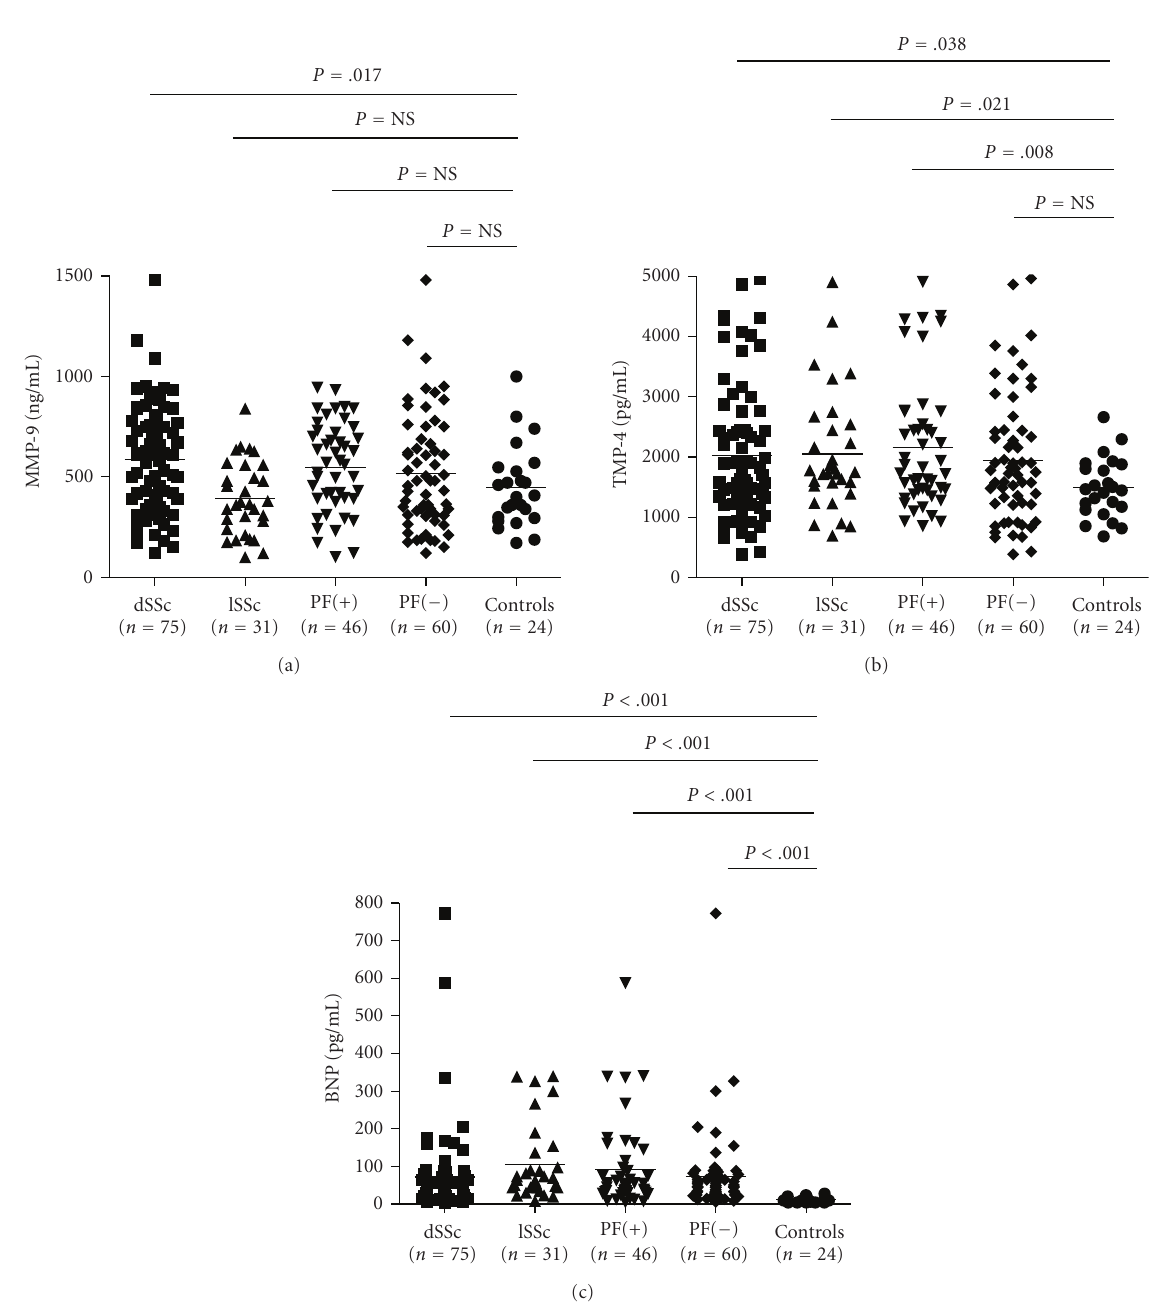
Figure 1: (a) MMP-9, (b) TIMP-4, and (c) BNP blood levels in SSc patients with di ff use (dSSc) and limited (lSSc) skin involvement as well as in those patients with pulmonary fibrosis (PF+) compared to healthy controls (Mann-Whitney test, NS denotes nonsignificant).